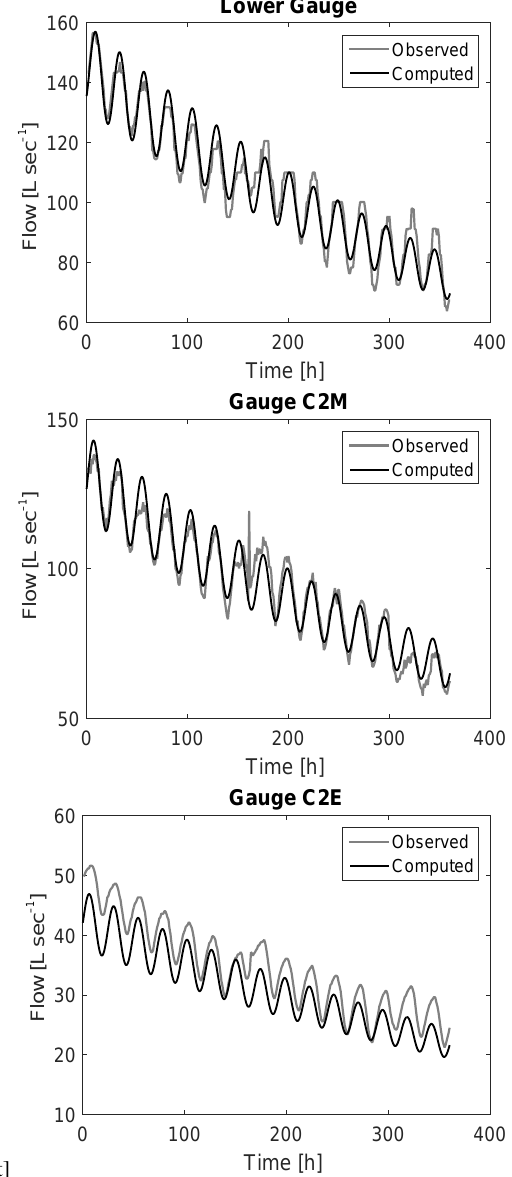
Figure 9. Observed streamflow and streamflow fitted using Eq. (16) at the outlet of the Dry Creek Experimental Watershed (top) and at two stream gauges upstream in the watershed: Con2Main (center) and Con2East